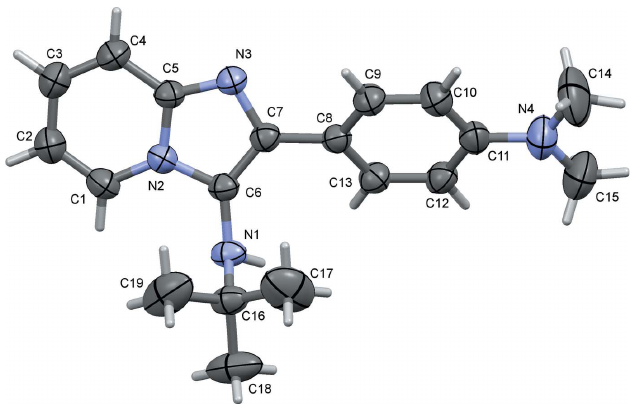
Figure 2 The molecular structure of compound (II), with the atom labelling. Displacement ellipsoids are drawn at the 50% probability level.